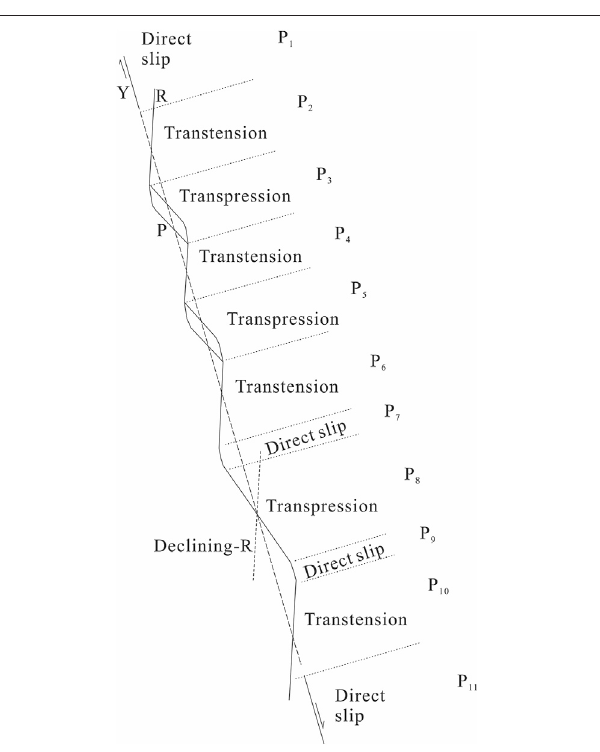
( Figure 7G ), transpressional – transtensional ( Figure 7H ), FIGURE 9 | Structures in a dextral strike-slip fault deformation belt with (Figure 7I), one-time activity and a small strike-slip distance.